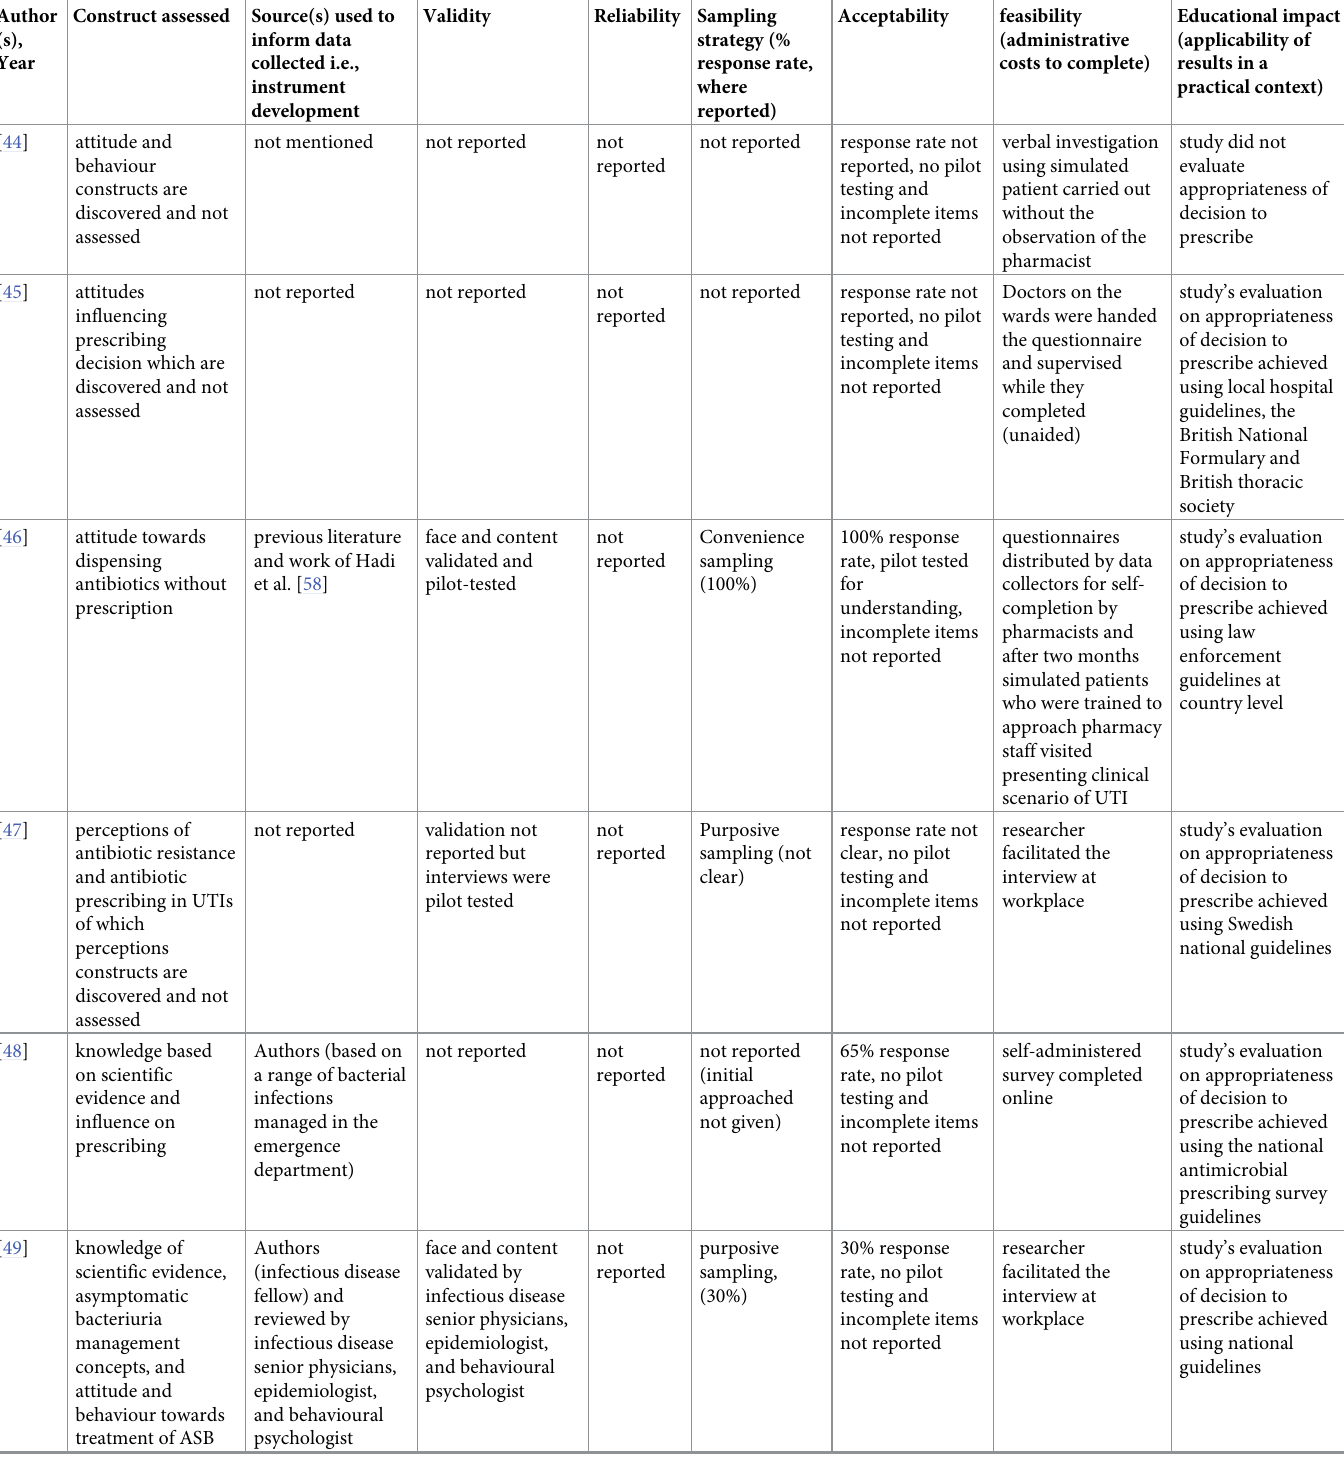
Table 6. Psychometric